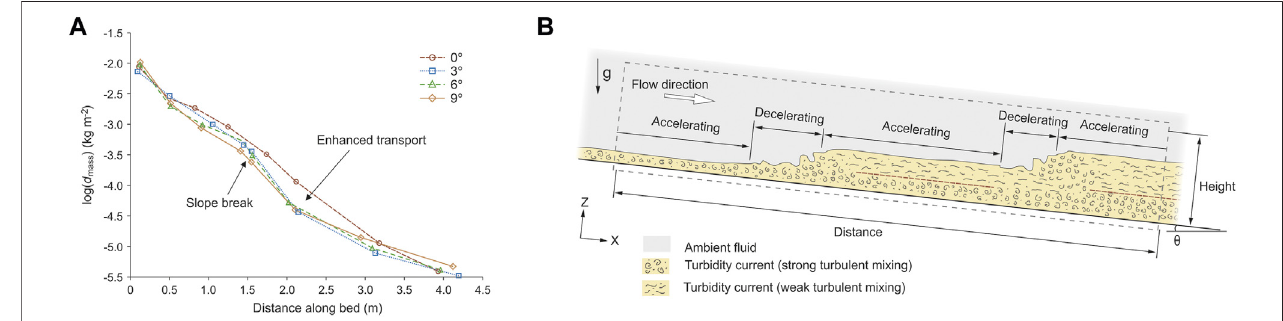
FIGURE 8 | (A) Pro fi les of sediment deposition (deposit mass per unit bed area; d mass ) with distance downstream for subcritical turbidity currents across a slope break onto a horizontal fl oor. These experiments did not show fl ow expansion, but demonstrated enhanced turbulence generation and development of periodic larger scale coherent fl ow structures downstream of the jump. Modi fi ed from Gray et al. (2005). (B) Schematic representation of a transcritical turbidity current showing a soft transition between supercritical and subcritical fl ow (i.e., without a hydraulic jump), consisting of a series of cascading instabilities. Modi fi ed from Salinas et